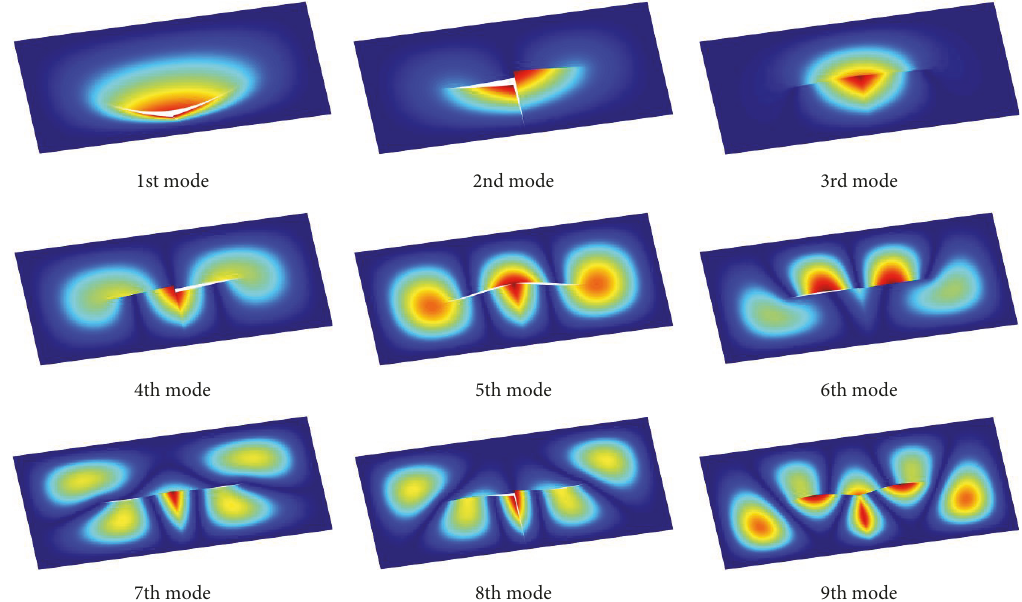
Figure 8: The first nine mode shapes of the CCCC plate with T-shaped crack.